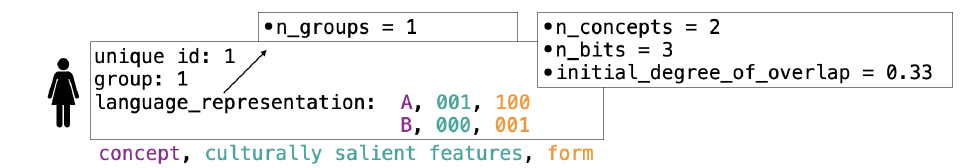
Figure 4. Example of an